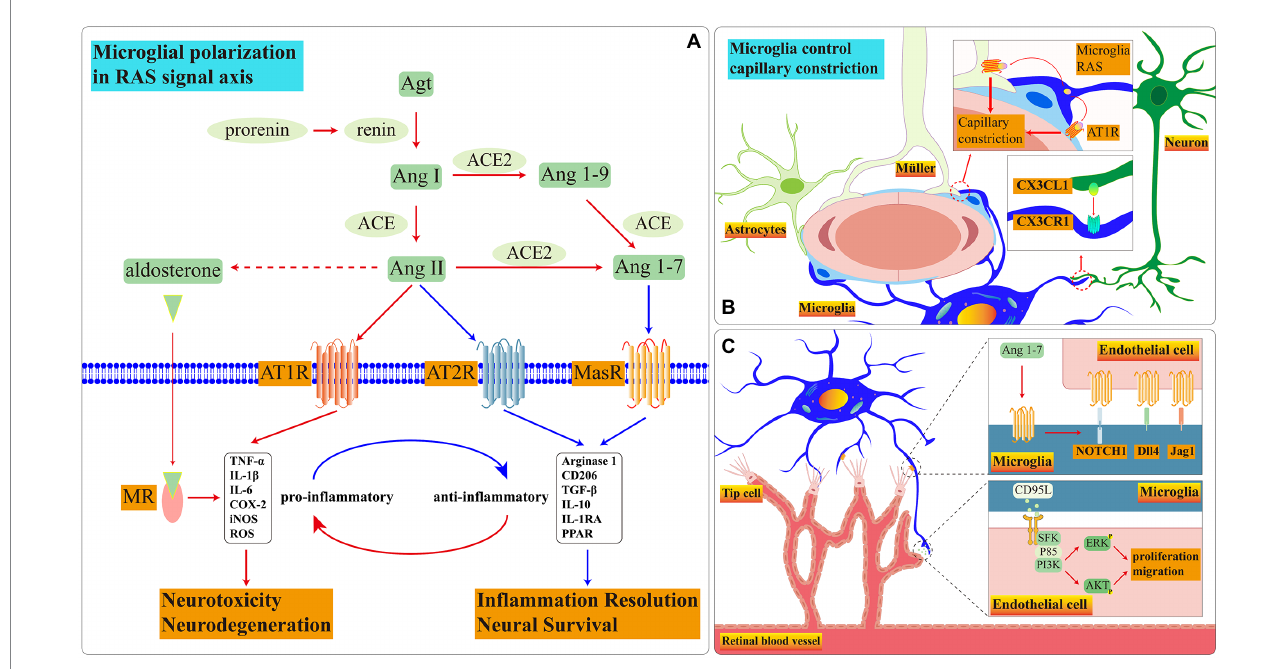
FIGURE 4 Schematic diagram of RAS signal pathways in microglia. (A) During disease onset, the RAS in microglia is imbalanced. Ang II is biased towards binding to AT1R and MR which promote microglia to pro-inflammatory functions. Among these receptors, the presence and function of AT2R in retinal microglia remain to be demonstrated. (B) The crosstalk among three glia cells controls blood flow rate through RAS. (C) Microglial MasR controls blood vessel formation during retinal